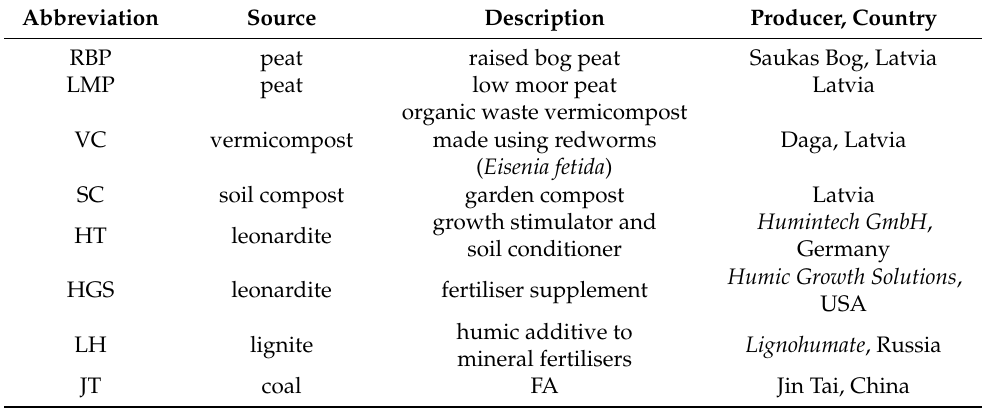
Table 1. Description of the